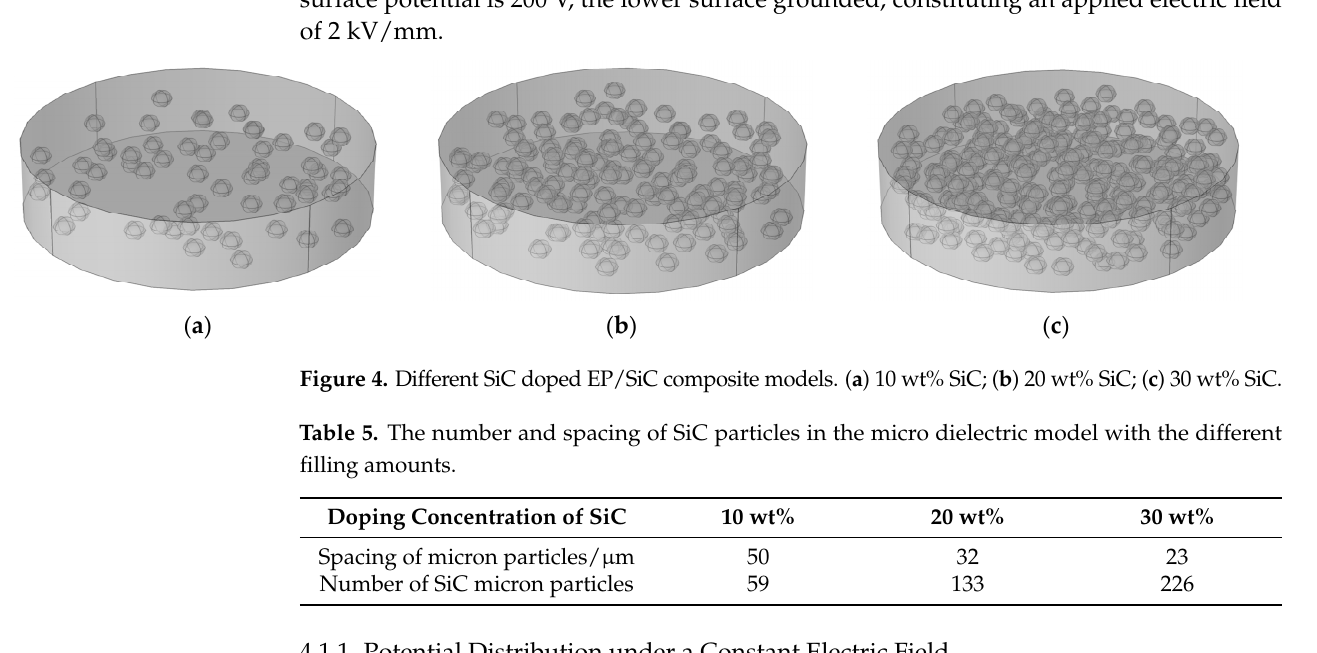
( b ) Figure 5. Potential and current density distribution diagram. ( a ) Potential distribution; ( b ) current density distribution. 4.1.2. Electric Field Distribution of SiC Cut Surface The electric field simulation clouds of the composite model with micron doping con- centration of 10 wt%, 20 wt%, and 30 wt% under 2 kV/mm electric field are shown in Figure 6, from which it can be seen that the dielectric electric field of the composite mate- rial is more uniform in the matrix or SiC, which is approximately equal to the applied electric field, and the dielectric tunneling effect is not obvious under this electric field, and the dielectric conductance at this time is mainly caused by the electrons on the SiC con- duction band under the action of thermal vibration The dielectric conductance at this time is mainly formed by the electrons in the SiC conduction band crossing the potential barrier